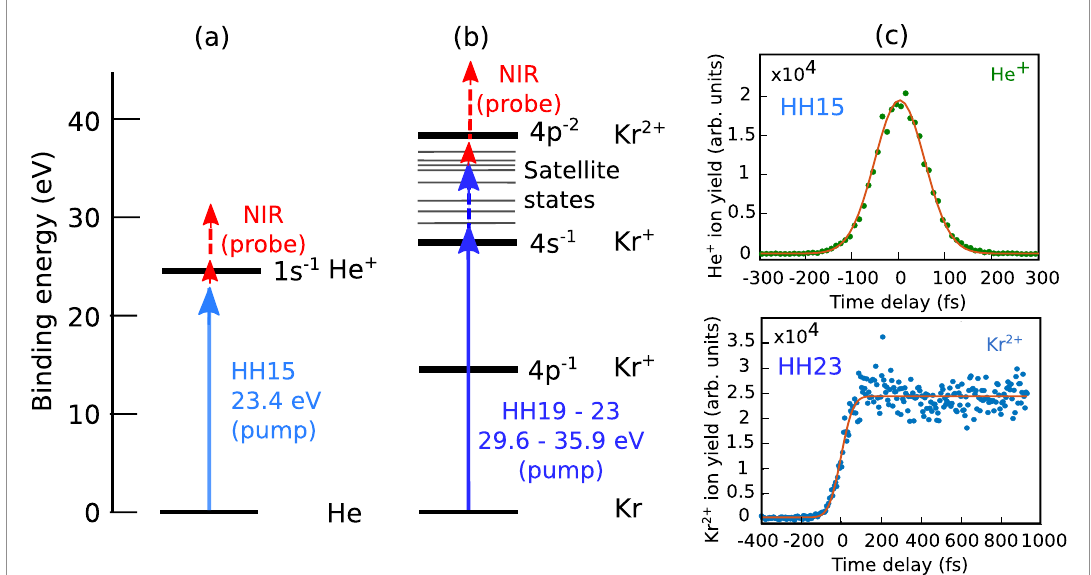
Figure 2. Illustration of the XUV-NIR pump-probe schemes and energy level diagrams for (a) direct two-color multiphoton ionization of He and (b) sequential XUV-NIR double photoionization of Kr. (c) Example of ion yields as a function of pump-probe delay showing direct multiphoton two-color ionization of He and sequential HH23-NIR pump-probe of Kr. He + ion yield (green dots) recorded at HH15, and fitted with a Gaussian curve (orange solid line). Kr 2 + ion yield (blue dots) are recorded at HH23, and fitted with a smoothed step function (red solid